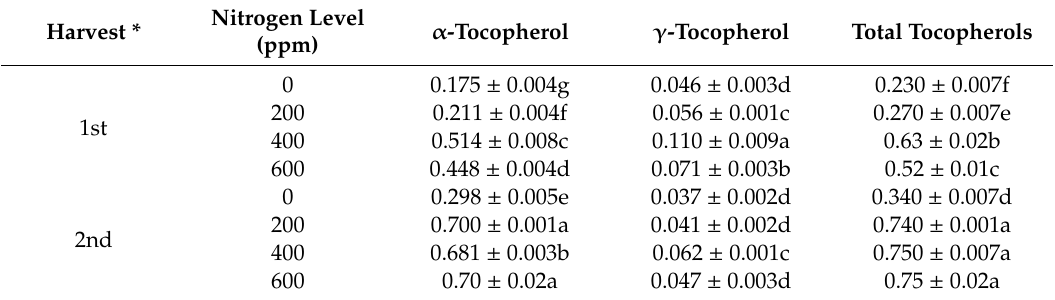
Table 3. Composition in tocopherols (mg / 100 g fw) of Centaurea raphanina subsp. mixta plants grown in 2 L pots under greenhouse conditions, in relation to harvesting time (1st and 2nd harvest) and nitrogen level (0–600 ppm) mean ± SD; n = 3).